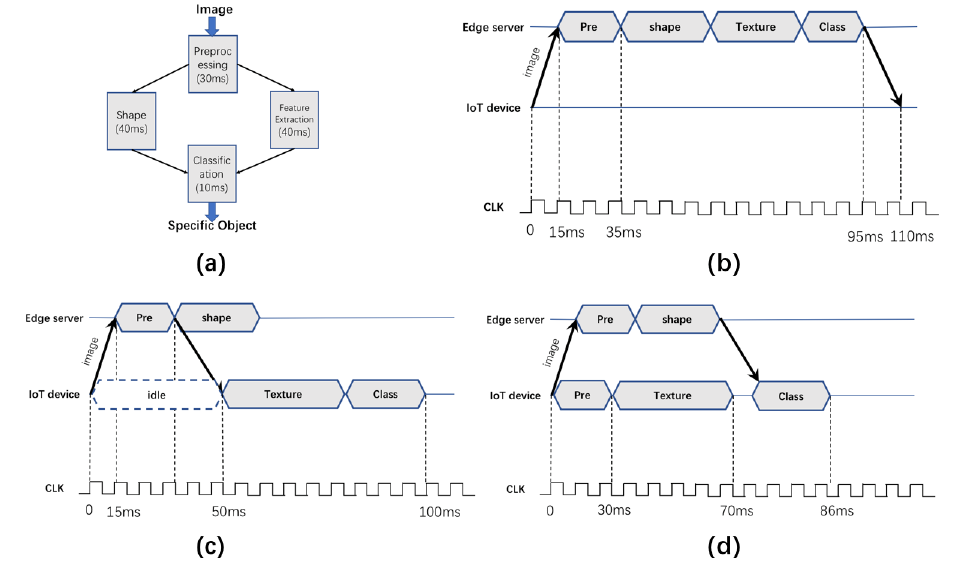
Figure 1. Case study. ( a ) the DAG of object recognition. ( b ) entire task offloading strategy ( c ) subtask offloading strategy. ( d ) Duplication subtasks offloading strategy